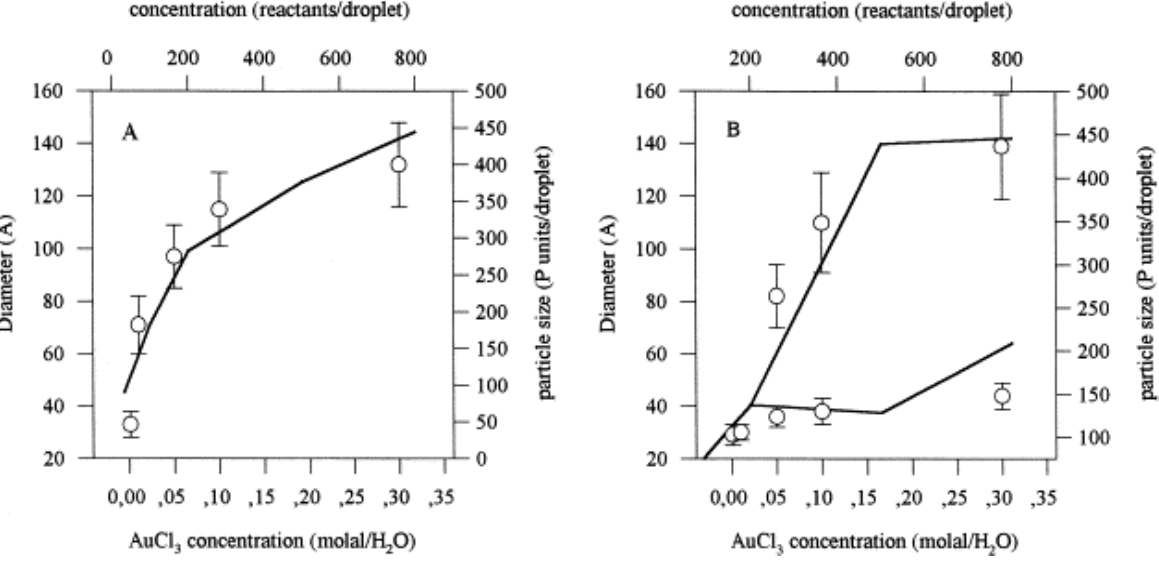
Figure 3. Particle size versus reactant concentration: ( A ) Symbols show Au particles prepared in DOBANOL-hexane-water; line shows simulation results ( f = 30, droplet size = 500). ( B ) Symbols show Au particles prepared in PEDGE-hexane-water (data obtained from reference  59  ); line shows simulation results ( f = 5, droplet size =